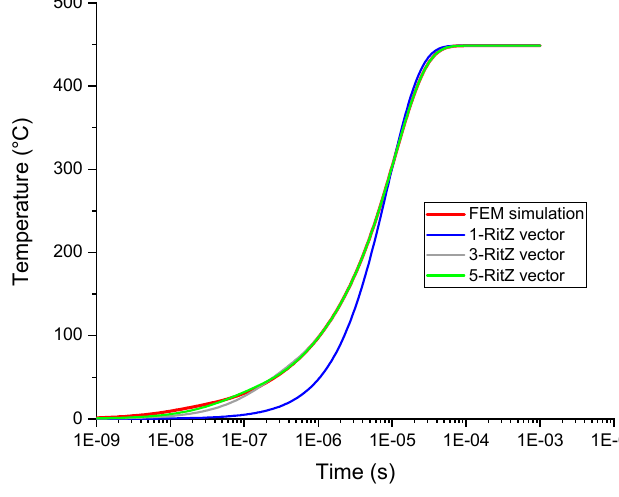
Figure 5. Comparison between FEM results and MOR results.